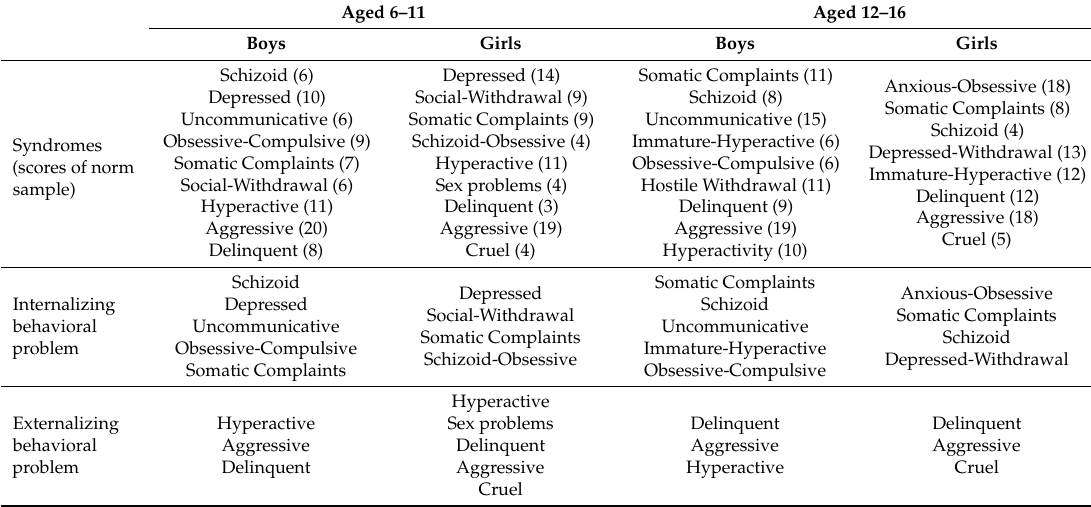
Table 1. Differences in the specific measured items and related scores of the norm sample by gender and